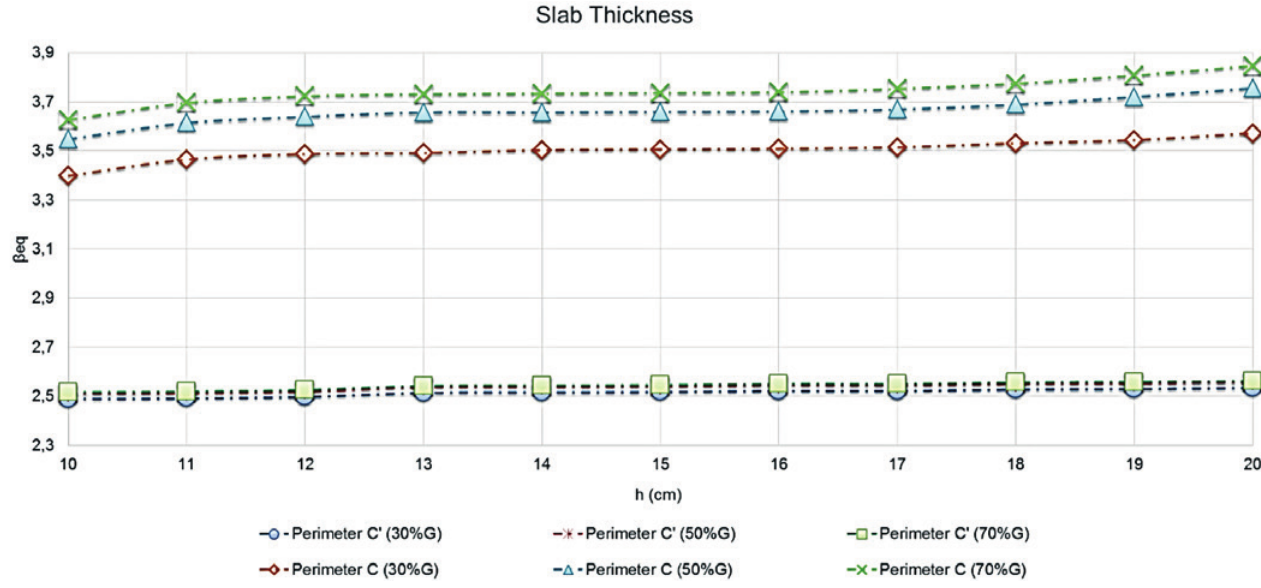
Results of reliability index